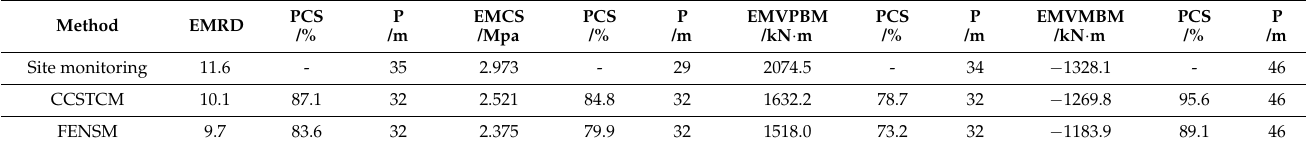
Table 4. The extremum comparison of the